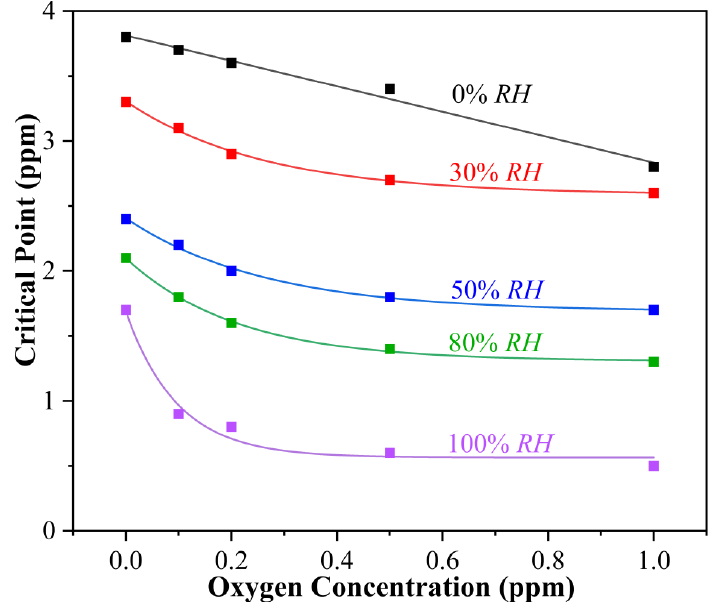
Figure 5. Fitted data of the CP in different LPG environments.